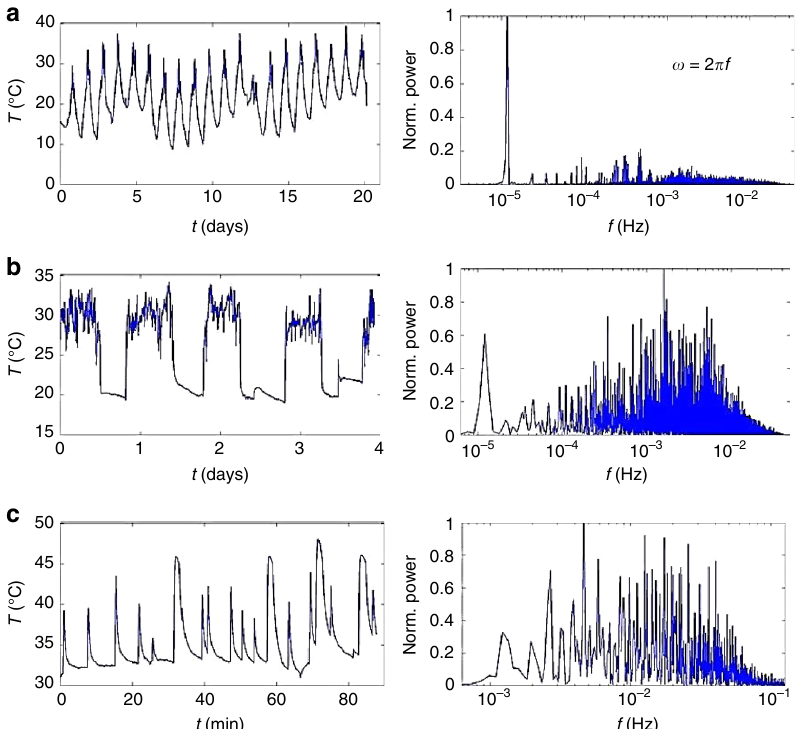
Fig. 4 Examples of ambient and transient temperature baths. a Temperature pro fi le (left) and FFT data (right) for a diurnal temperature cycle. b Temperature pro fi le (left) and FFT data (right) for a wearable temperature sensor (SHTC1 Smart Gadget with Bluetooth TM interface from Sensirion). c Temperature pro fi le (left) and FFT data (right) obtained from the exhaust port of a Dell Latitude E6330